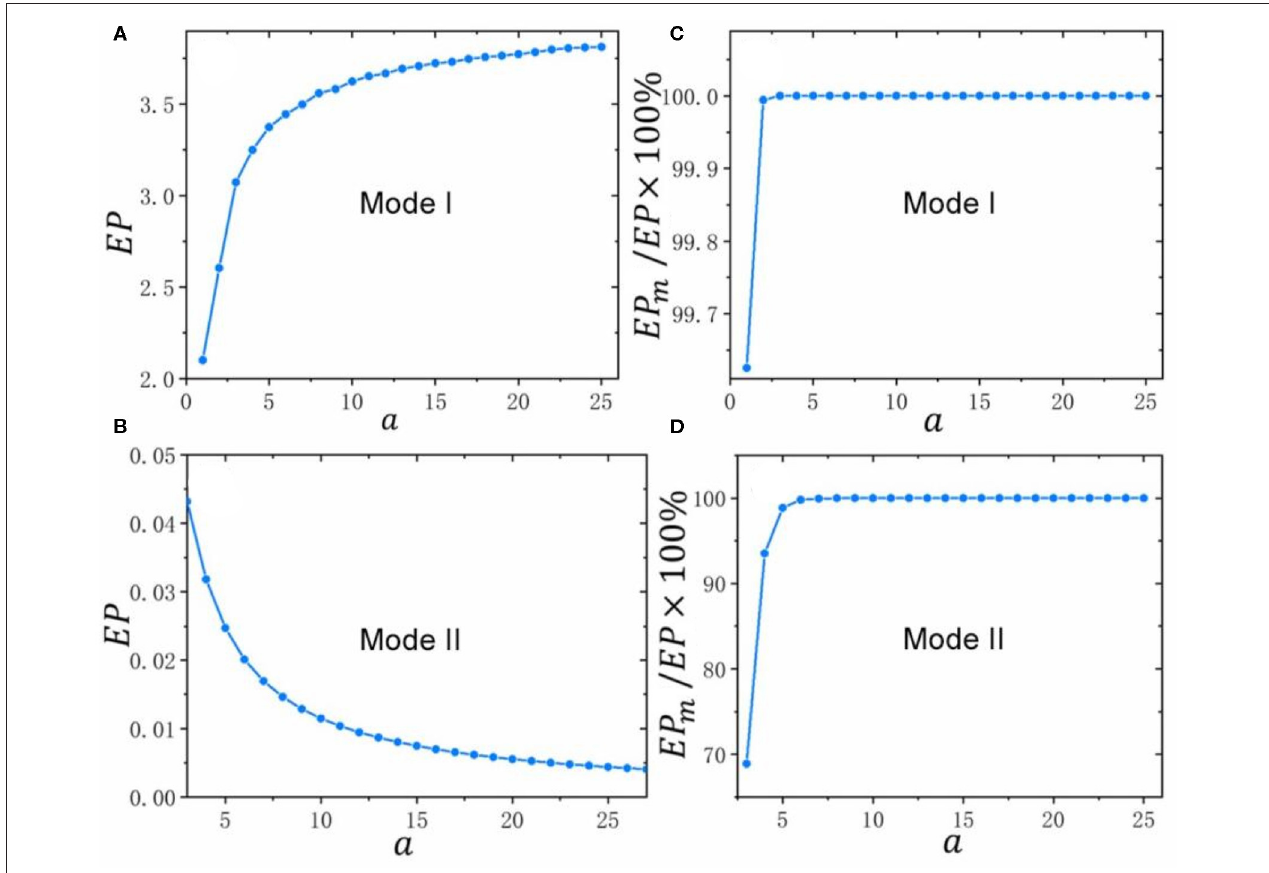
FIGURE 5 | The influences of the strength of external stimulation on energy dissipation in Mode I and II. The values of all parameters are listed in Table S1 . (A,B) The relation curves between total energy dissipation EP and a in Mode I and II; (C,D) The relation curves between the percentages of energy dissipation in the synthesis-degradation process of ROCK (i.e., EP m ) in total energy dissipation (i.e., EP ) and a in Mode I and